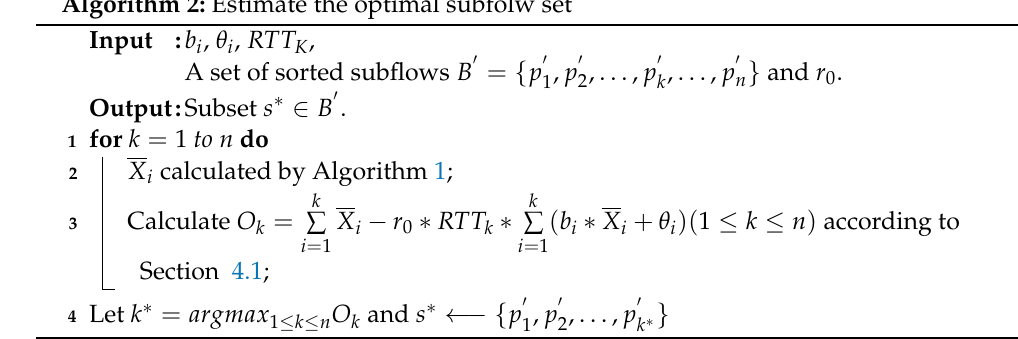
Algorithm 2: Estimate the optimal subfolw